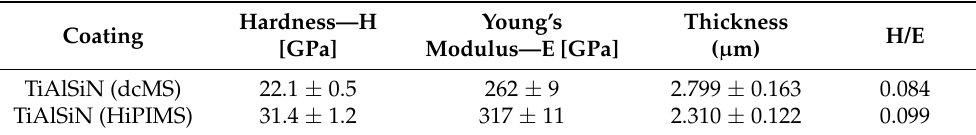
Table 4. Average hardness, Young’s Modulus, thickness, and H/E ratio values for both TiAlSiN